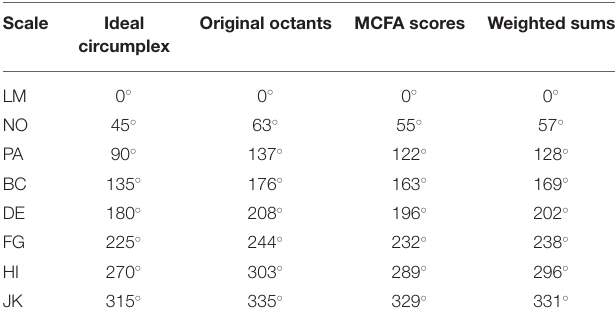
TABLE 5 | Circular angles of the inventory of interpersonal problems for original and reproduced